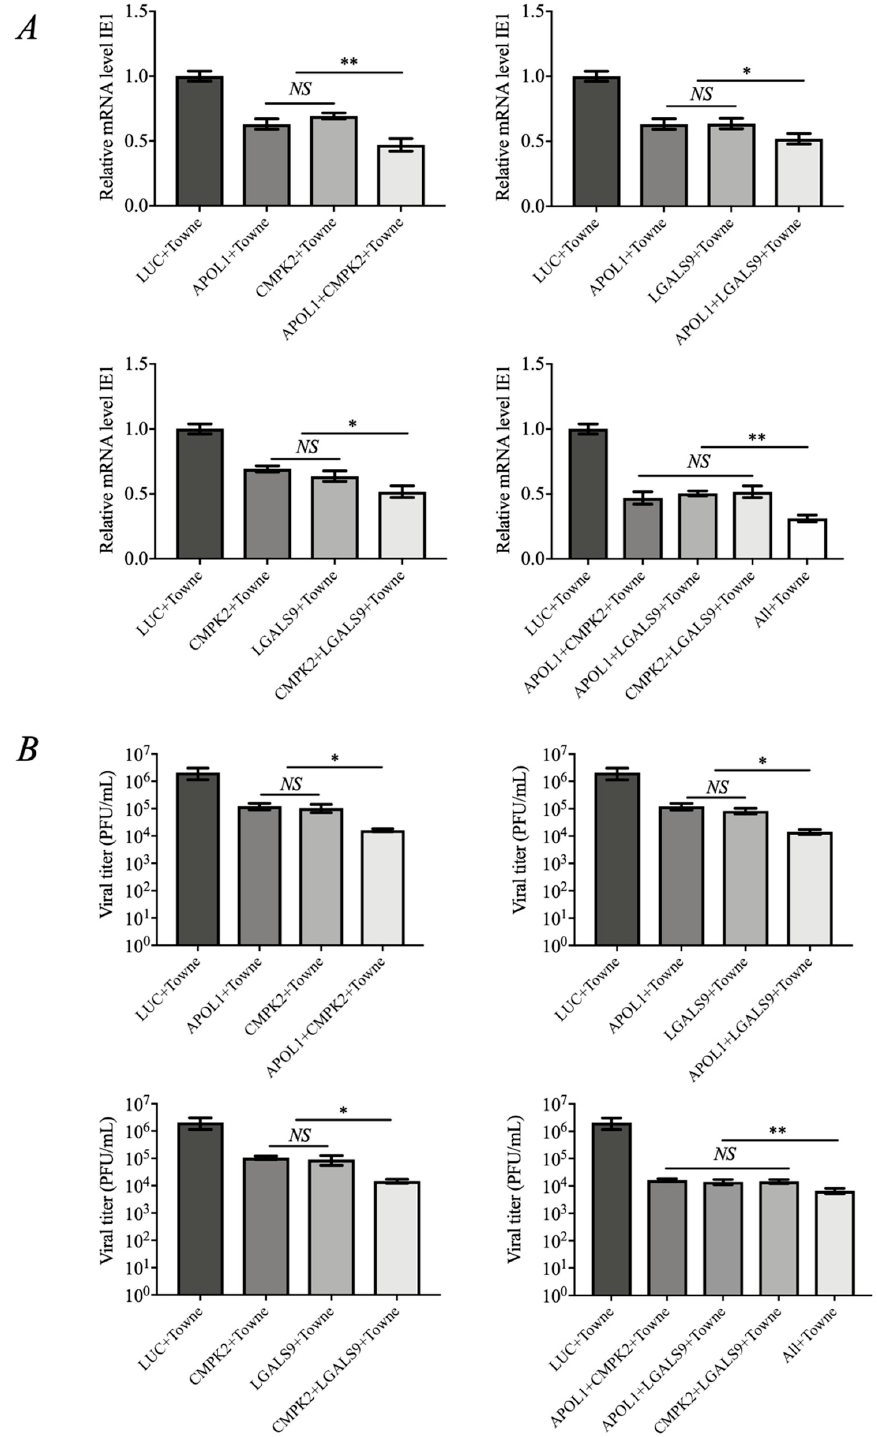
Figure 3. A combination of APOL1, CMPK2, and LGALS9 exhibits synergistic anti-HCMV effects. ( A ) RT-qPCR detection of the synergistic effects of APOL1, CMPK2, and LGALS9 on the expression of the HCMV-Towne IE1 gene (24 h). ( B ) Virus titer determination APOL1, CMPK2, and LGALS9 synergistic effects on HCMV-Towne replication (7 d). Data are shown as mean ± SD. * p < 0.05, ** p < 0.01, NS denotes not significant ( p > 0.05). Data are representative of three independent experiments with similar